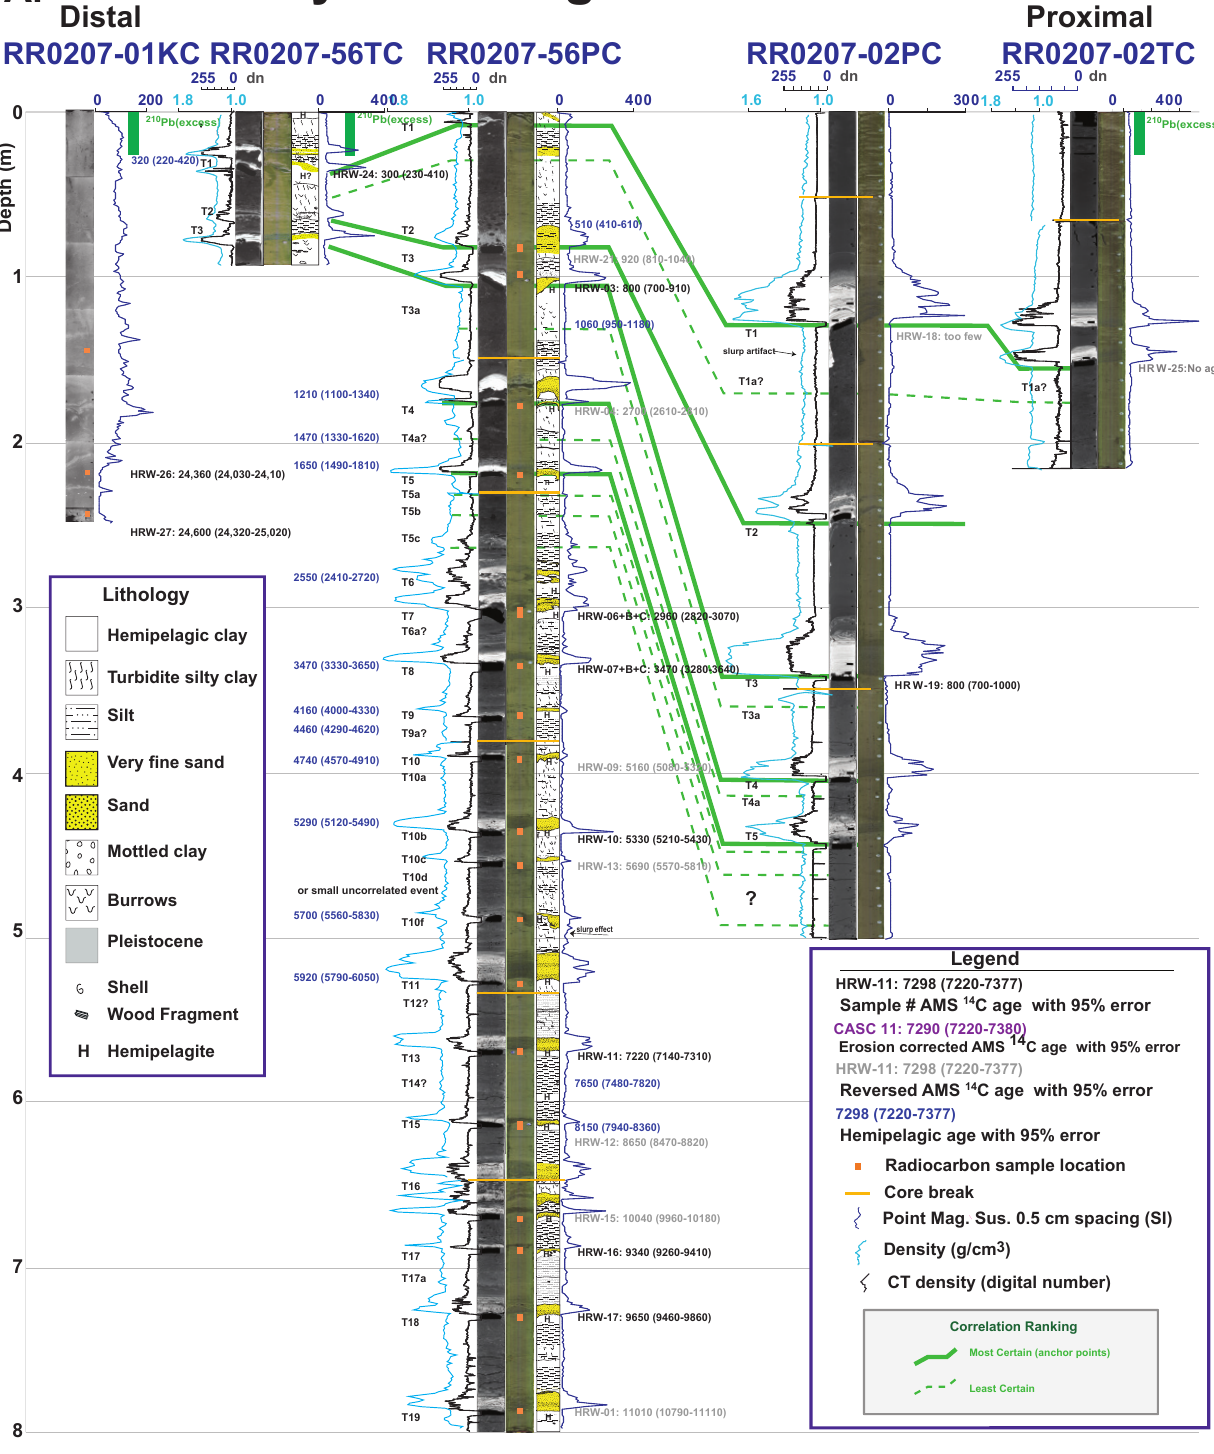
Fig. 7. Cascadia slope basin cores at Hydrate Ridge West Basin: RR0207-01KC, 56PC/TC, and 02PC/TC (Fig. 3). (A) Site-correlation diagram for Hydrate Ridge Basin West (HRBW) cores. Individual coarse pulses in these turbidites, 02PC/TC in particular, are well defined, consistent with their proximal setting. MSCL data are plotted along with CT density: gamma density in light blue, CT density in black, and magnetic susceptibility in dark blue. Calibrated radiocarbon ages (Goldfinger et al., 2012) are reported with 95% error. 210 Pb activity (“excess”), measured in some cores, shows to what depth recent sediments were deposited (approx. 150yr; Noller, 2000).